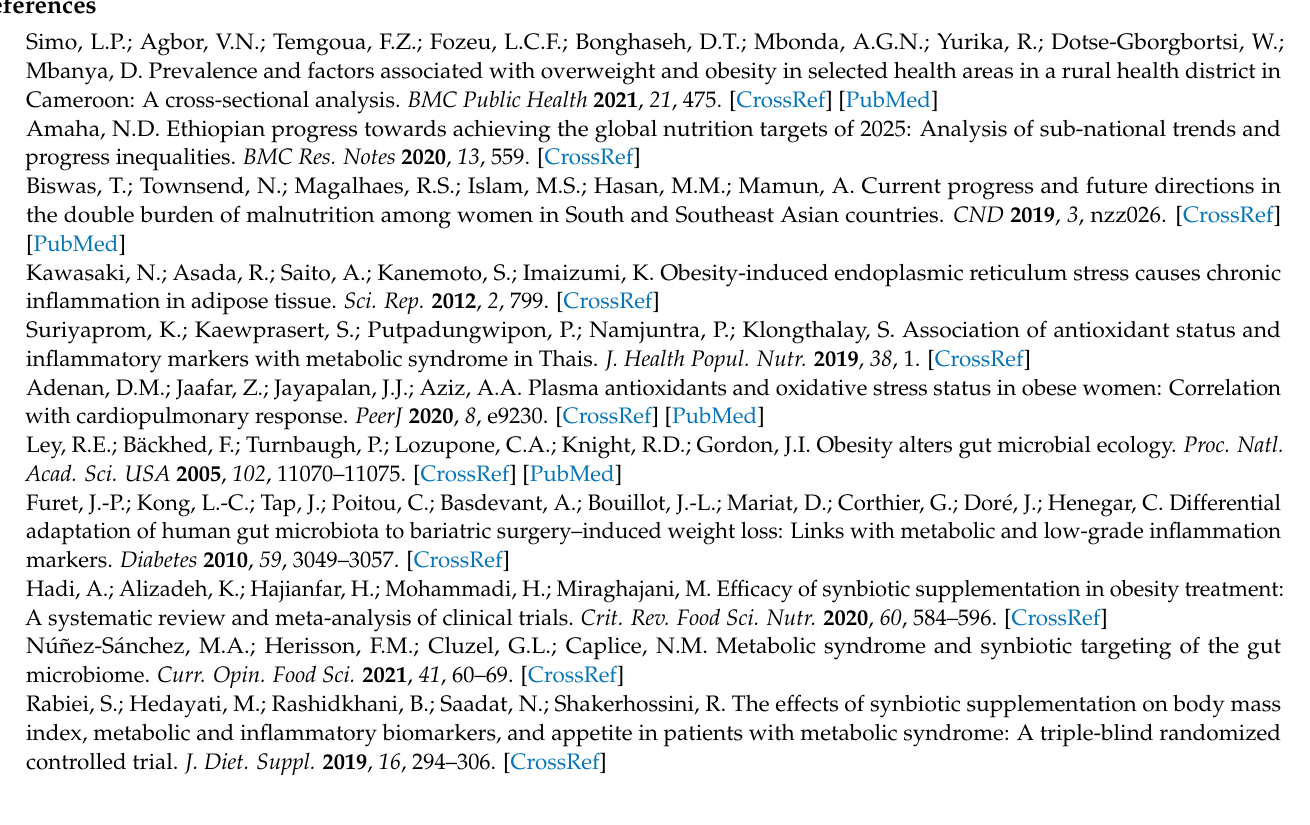
plementation. Table S2: Effect of 12-week synbiotic intervention on kidney and liver function in overweight and obese subjects. Table S3: the three-day food record in placebo and synbiotic groups during the